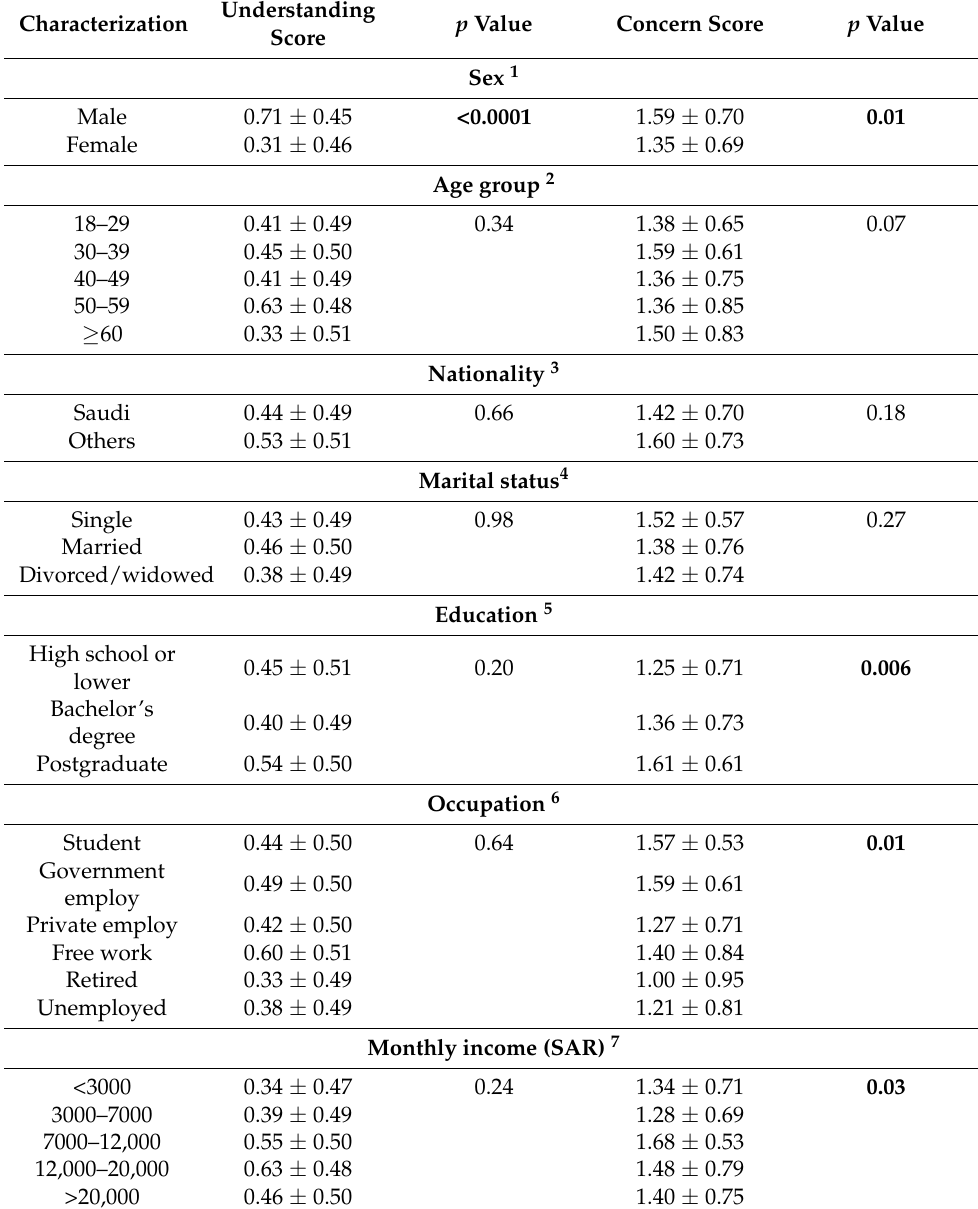
Table 2. Participants’ understanding of climate change and concern about climate change scores stratified based on sociodemographic